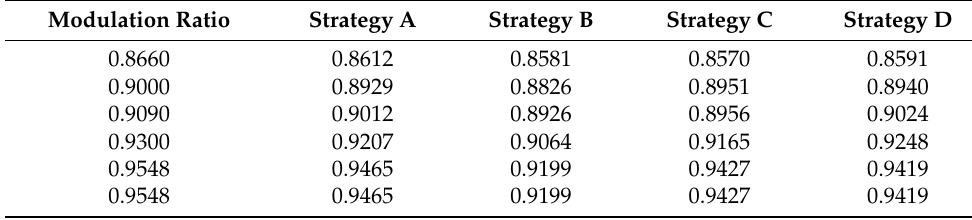
Table 2. Experimental results of fundamental modulation ratio output by each strategy.